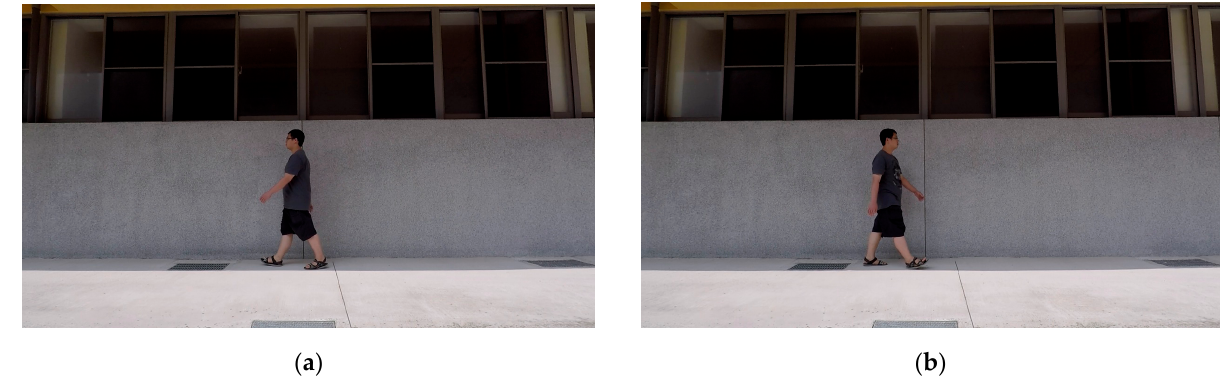
Figure 4. ( a , b ) Types of left and right walking.